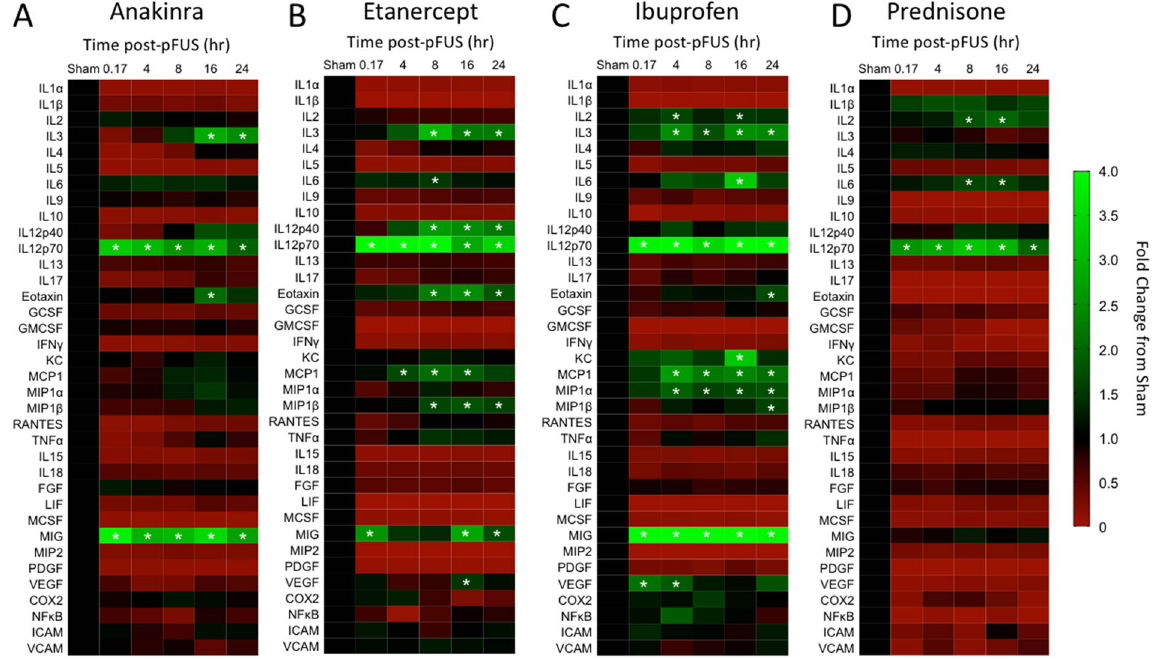
Figure 4. Anti-inflammatory drugs inhibit the molecular response to pFUS in kidneys. Heat maps showing molecular fold changes following pFUS when mice were pretreated with the indicated drug. Increases are indicated in green while decreases are shown in red. For each molecule, all time points were compared to a sham kidney (no drug, no pFUS) using ANOVA with Bonferroni post-hoc tests. Time points with p values < 0.05 were considered statistically significant and indicated by asterisks.